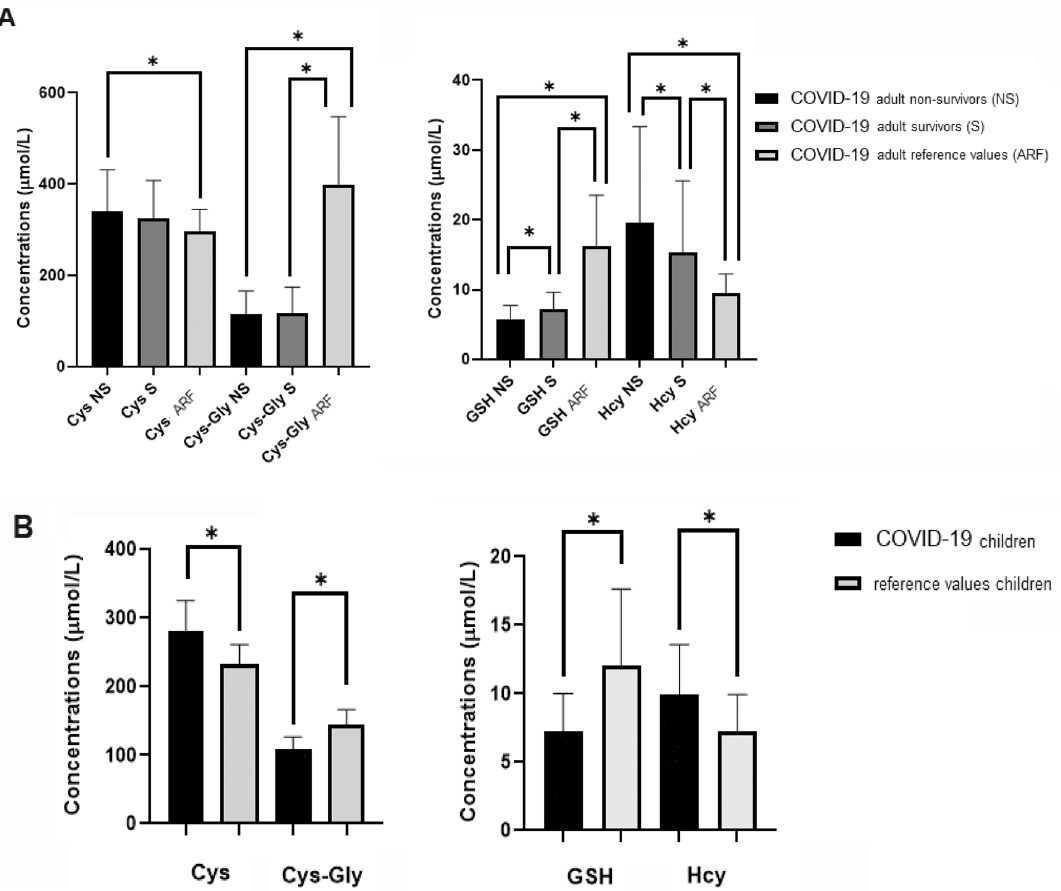
Figure 1. Low molecular weight amino thiols in adults and children. Low molecular aminothiols levels (LMWTs: cysteine (Cys), cysteinyl-glycine (Cys-Gly), glutathione (GSH), and homocysteine (Hcy)) in non- survivors (NS) and survivors (S) adults, compared to adult internal reference values (ARF) concentrations (panel A ; *p < 0.050). LMWTs levels in children cohort compared to LMWTs children internal reference values (panel B ; *p <